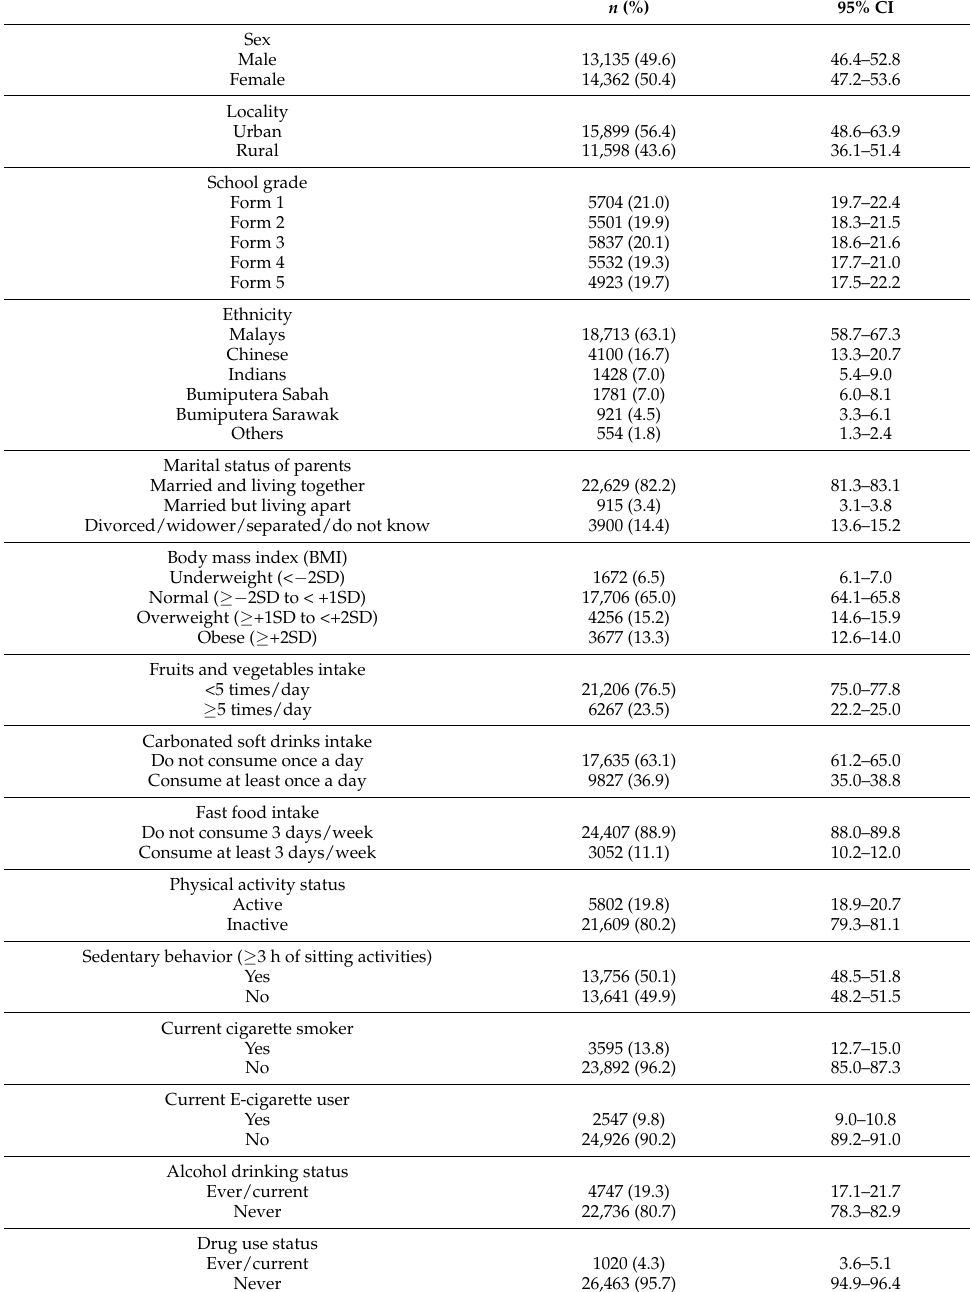
Table 1. Demographic and lifestyle characteristics of participants ( n =